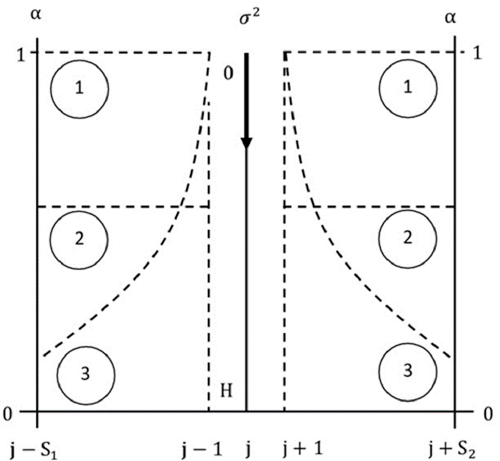
Figure 7. Ambiguity and context manipulations. The context strength is decreased by decreasing 𝛼 , context noise is increased by increasing 𝜎 (cid:2870) , 𝑆 (cid:2869) and 𝑆 (cid:2870) are the number of left and right context stimuli, respectively, and 𝑗 is the spatial or time